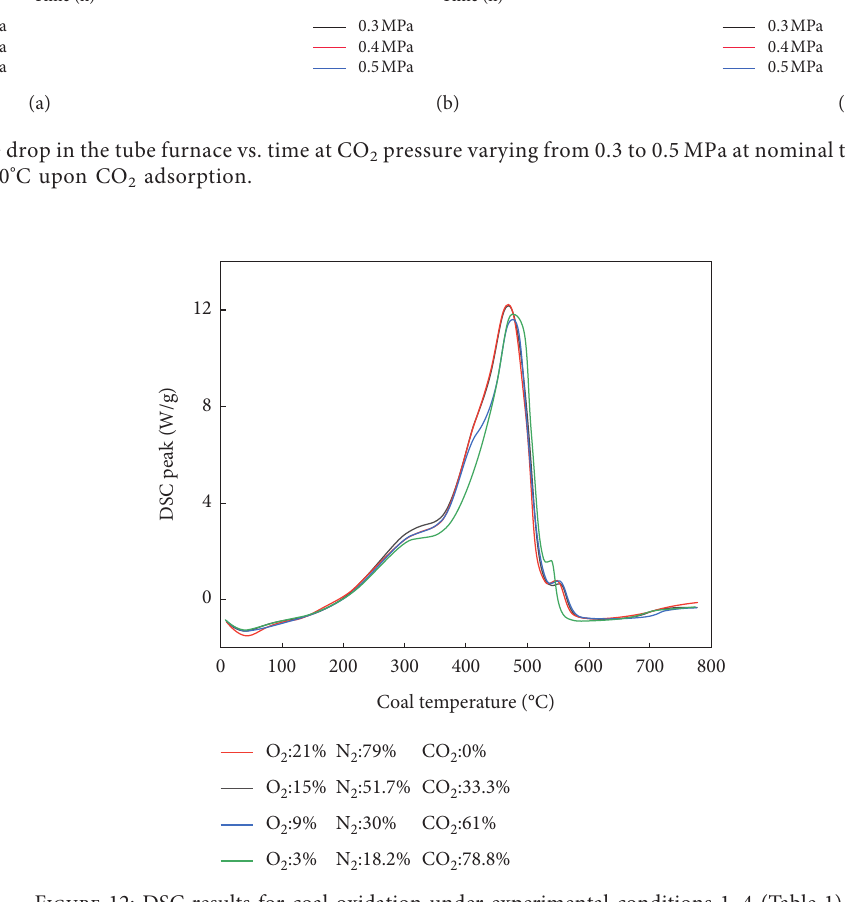
Figure 12: DSC results for coal oxidation under experimental conditions 1–4 (Table